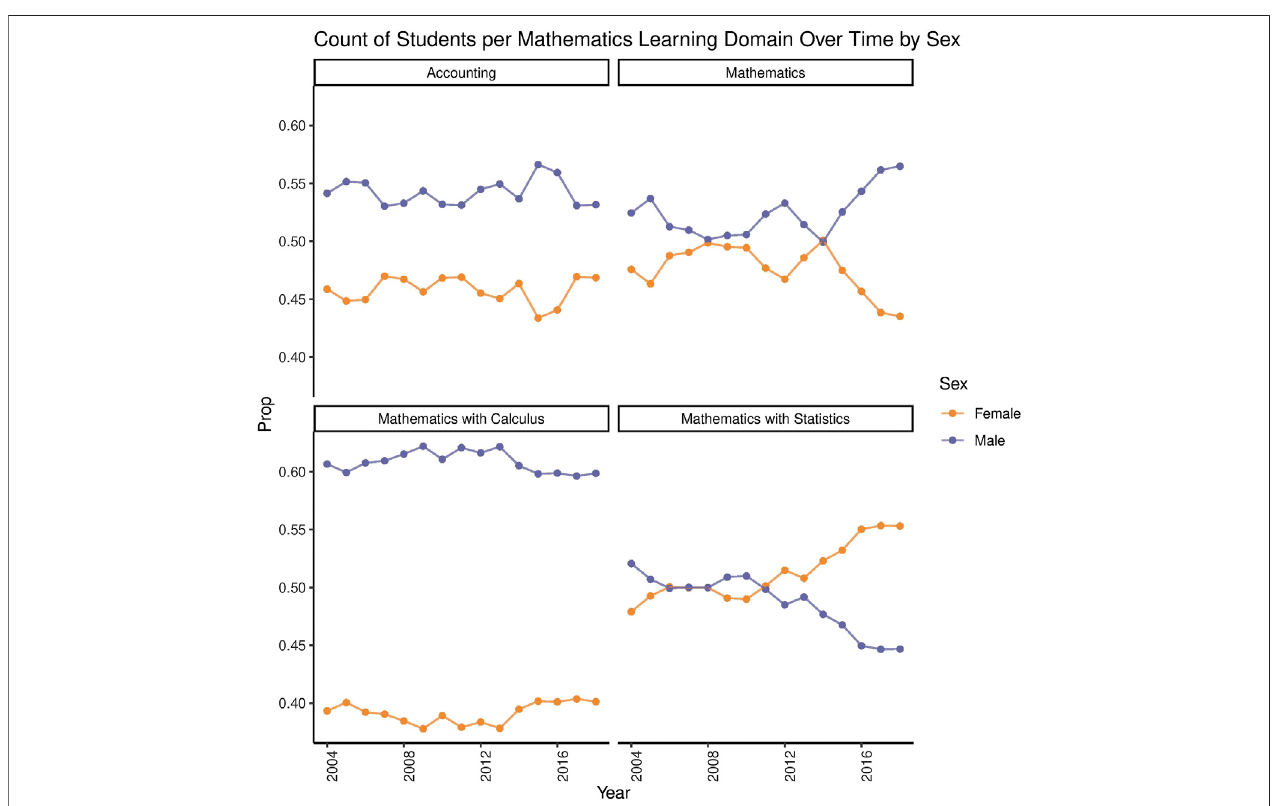
FIGURE2 | Mathematics Participation Rates Across Years bySex. Theseplots show the participation of male and female students in key mathematics subjects in Year13from2004to2018.Therehavebeenrelativelyevenlevelsofparticipationinmathematicssubjectsovertime,exceptcalculuswheremalestudentscontinuetobe enrolled in greater numbers. Data retrieved from Ministry of Education